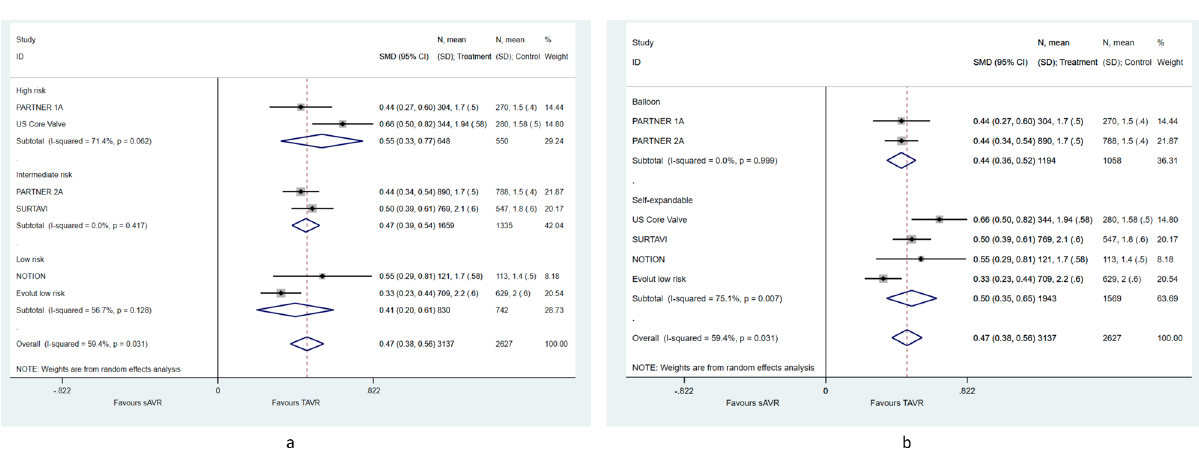
Figure 4. Pooled mean difference of post-procedural effective orifice area at 2 years, according to ( a ) surgical risk on inclusion and ( b ) transcatheter heart valve